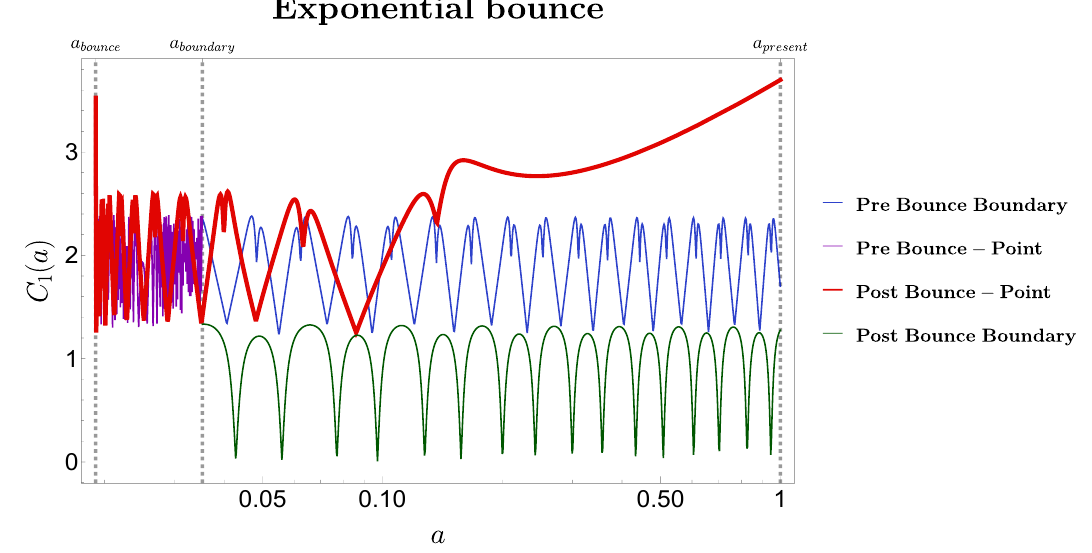
Figure 29: Linearly weighted complexity in different regions against scale factor. In Fig. 29 and Fig. 30 the complexity measures